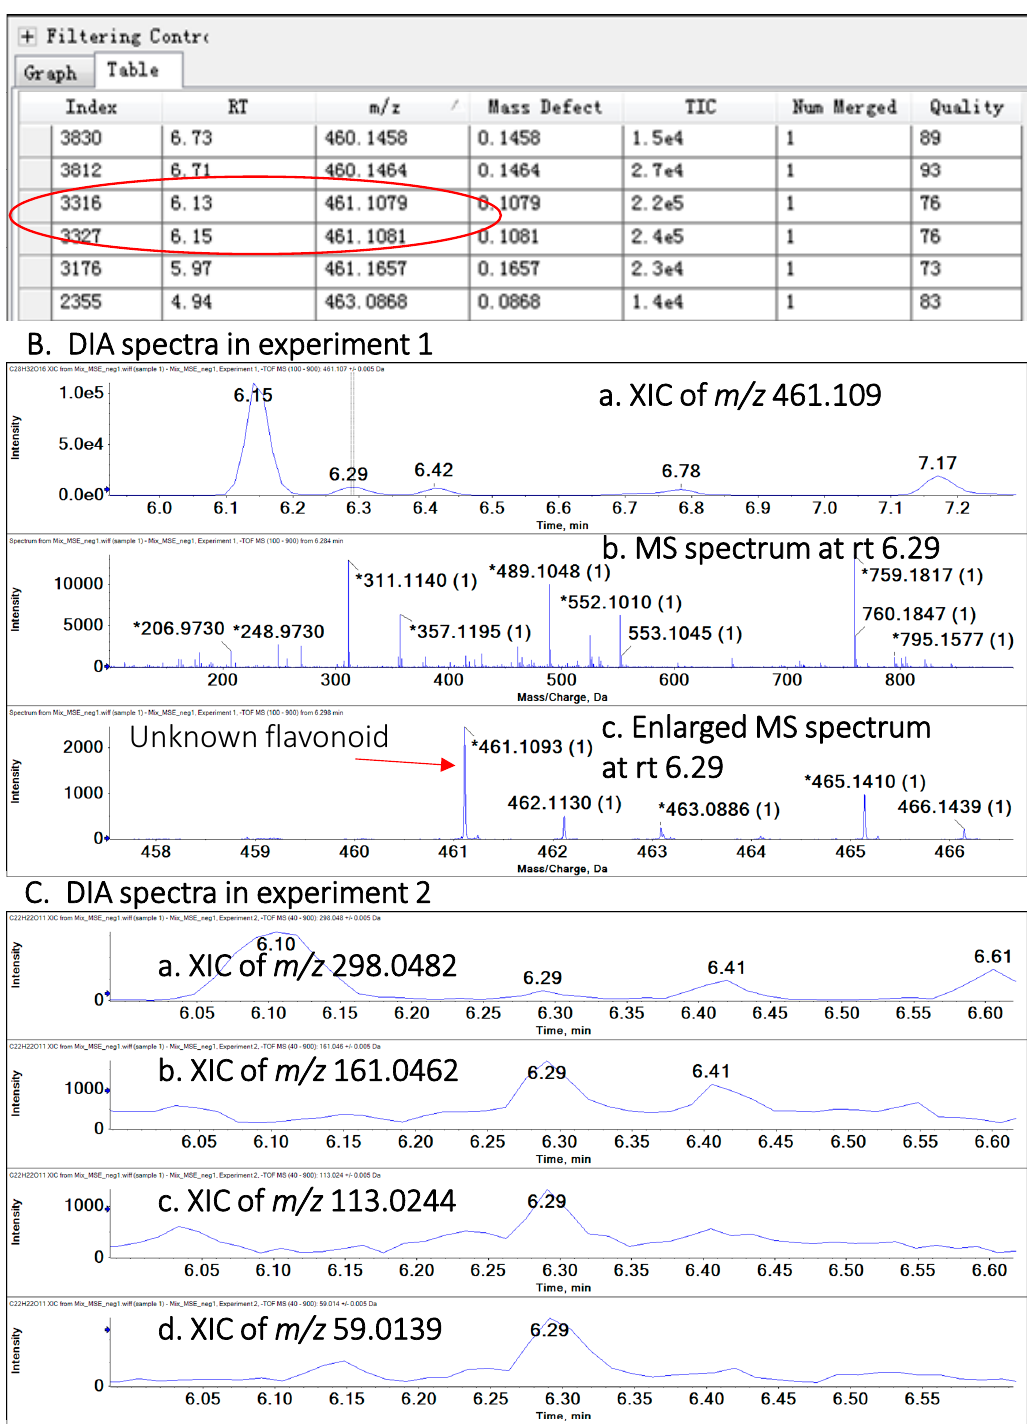
Figure 2. Example illustrating how DIA serves to characterize endogenously low polyphenols missed by IDA scan. ( A ) IDA list showing the acquired results of ions around m/z 461.109 and RT 6.29 minutes. ( B ) The XIC of m/z 461.109 and its corresponding spectrum an RT 6.29 minutes in DIA experiment 1. ( C ) XIC of product ions ( m/z 298.0842, m/z 161.0462, m/z 113.0244, m/z 59.0139) of m/z 461.109 at RT 6.29 minutes in DIA experiment 2. XIC, extracted ion chromatogram; RT, retention time.